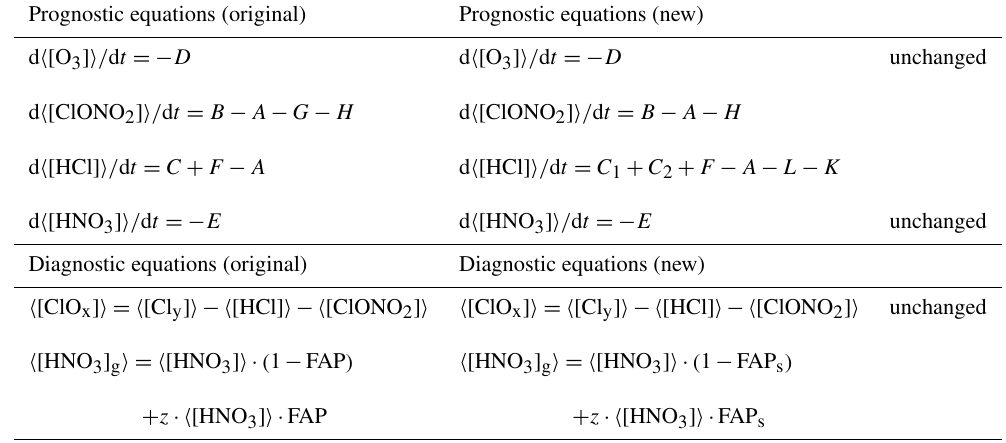
Table 1. List of equations used in the original and new Polar SWIFT version. Terms A to L are specified in Table 2. (cid:104) ... (cid:105) is the vortex mean, z is a free fit parameter. FAP and FAP s are fractions of the polar vortex below different threshold temperatures for the formation of PSCs (see Sect.